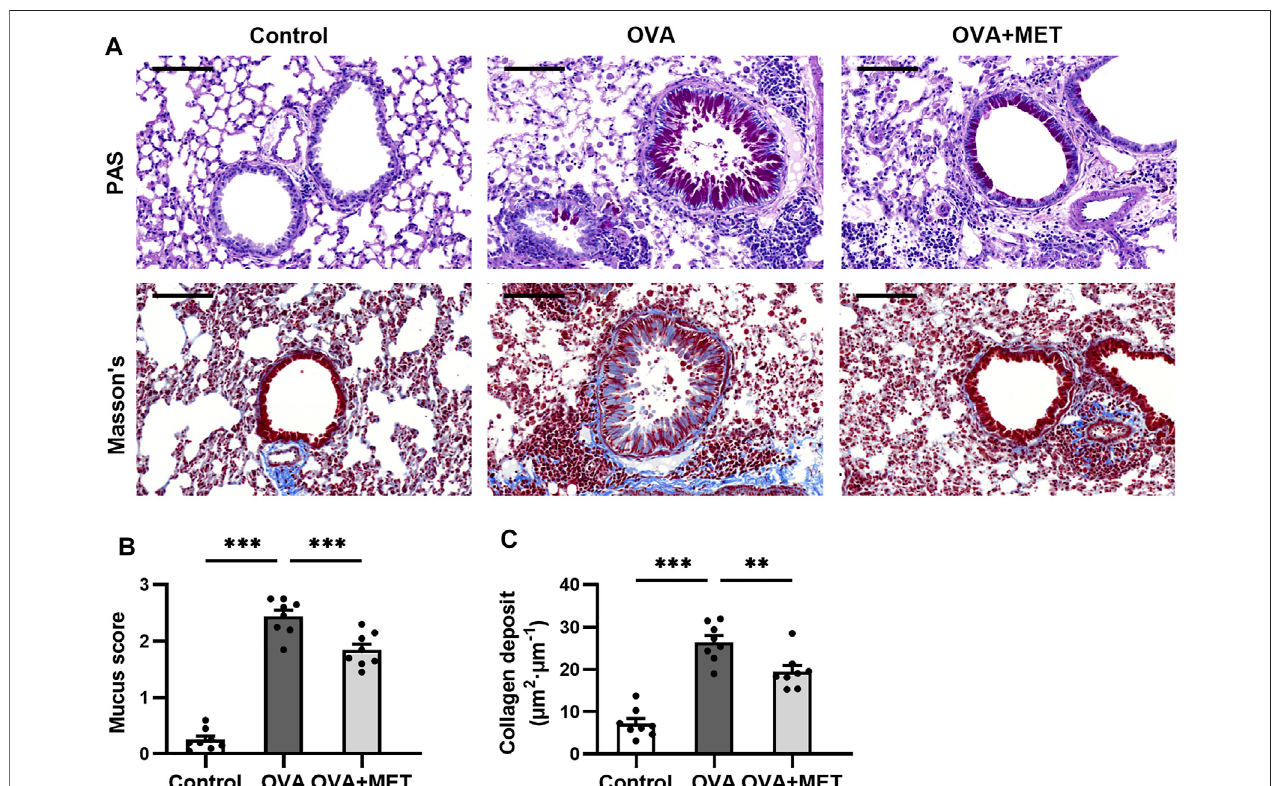
FIGURE2| MetforminattenuatesairwayremodelinginhistologyofOVAsensitizedandchallengedmice. (A) .RepresentativeimagesofPAS-stainedandMasson ’ s trichrome-stained lung sections from each group. (B) . Blinded scoring of percentage of PAS positive epithelial cells. (C) . Blinded quantitative analyses of area of peribronchial Masson ’ s trichrome staining by Image-Pro Plus. Data were presented as mean ± SEM ( n (cid:1) 8 animals, 20 bronchioles/3 sections of an animal, each bronchiole with 100 – 200 μ m of internal diameter). All images are at × 200 magni fi cation. Scale bar (cid:1) 100 μ m * p < 0.05, ** p < 0.01, *** p < 0.001.